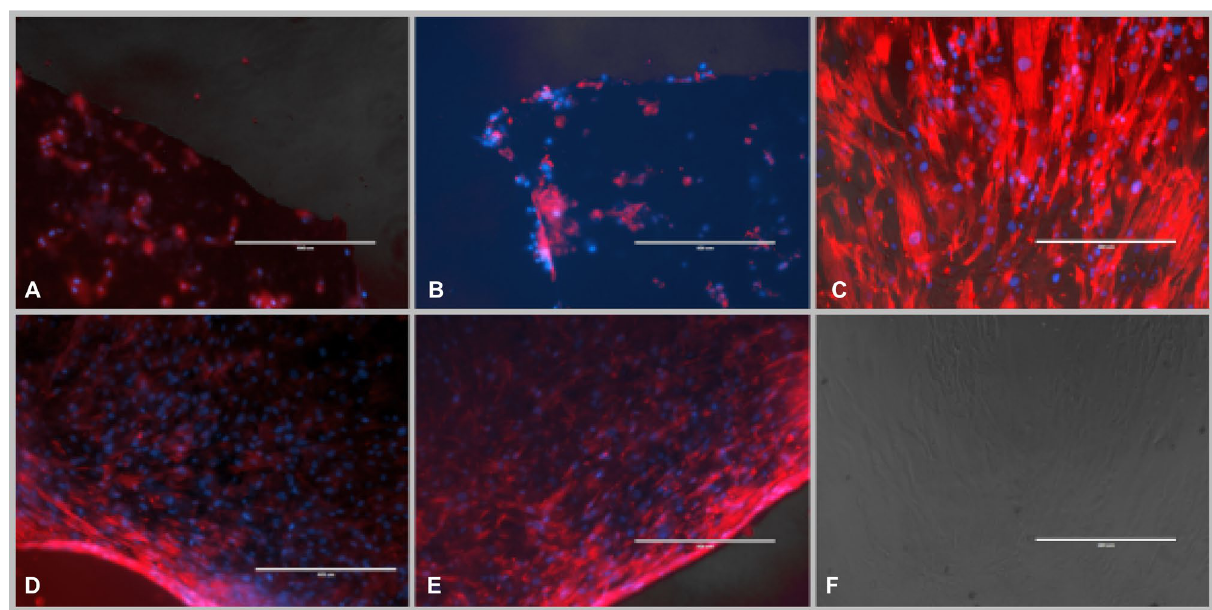
Figure 3. ASCs F-actin fibbers on Ni NW: ( A , B ) ADSC on NW placed in adherent culture plates; few visible cell bodies with rounded shape and predominant marginal distribution; ( C ) ASCs cultured on regular adherent culture plate demonstrating their fibroblastic like morphology; ( D , E ), ASCs on NW placed in ultra- low adherent culture plates (ULA) cells occupy entire NW surface and form intermingled cellular networks; increased number of cells demonstrated by the density of cellular nuclei; ( F ) ASCs on regular culture substrates, transmission optic electron microscope. In red- F actin fibers stained with phalloidin (Texas Red) in blue cell nuclei stained with